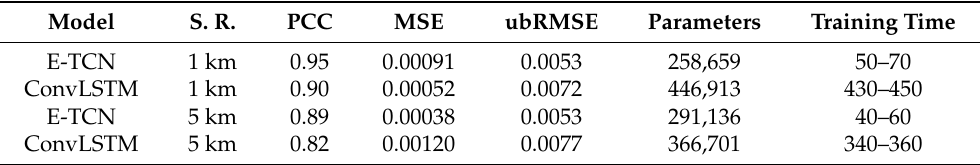
Table 2. Error metrics for the predicted land surface temperature values, number of trainable param- eters and training time (in msec per step), when the dataset consisted of images of 28 × 28 pixels ob- tained from a region in Sweden. The second column shows the spatial resolution (S.R.) of the dataset. Model S. R.